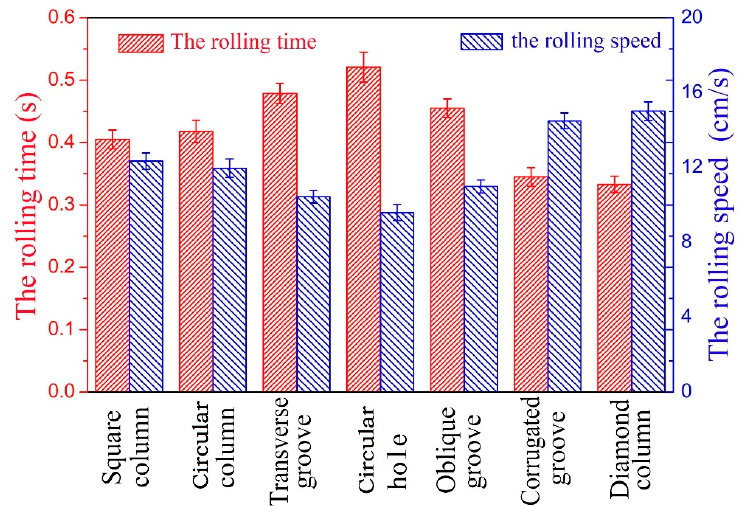
Figure 10. Rolling time and average rolling speed of the droplet dripping from the different texture surfaces. texture